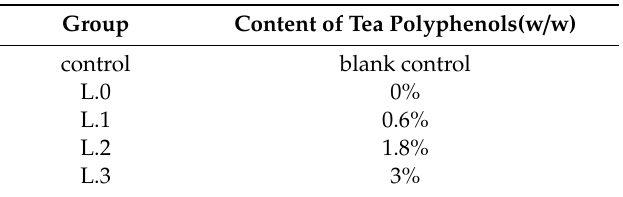
Table 1. The grouping